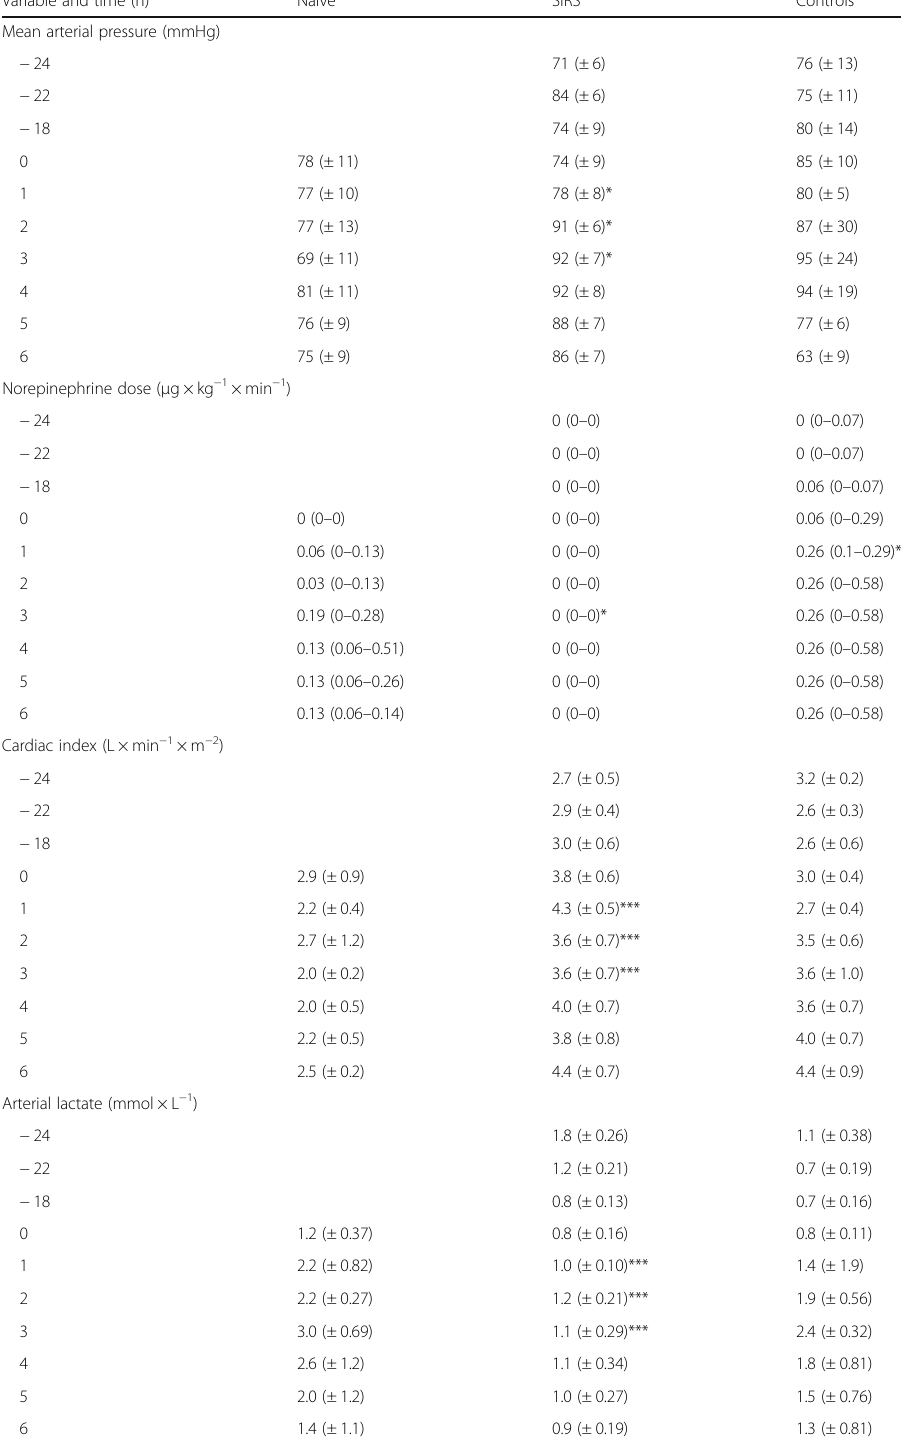
Table 1 Physiological variables, norepinephrine dose and blood count during the experiment Variable and time